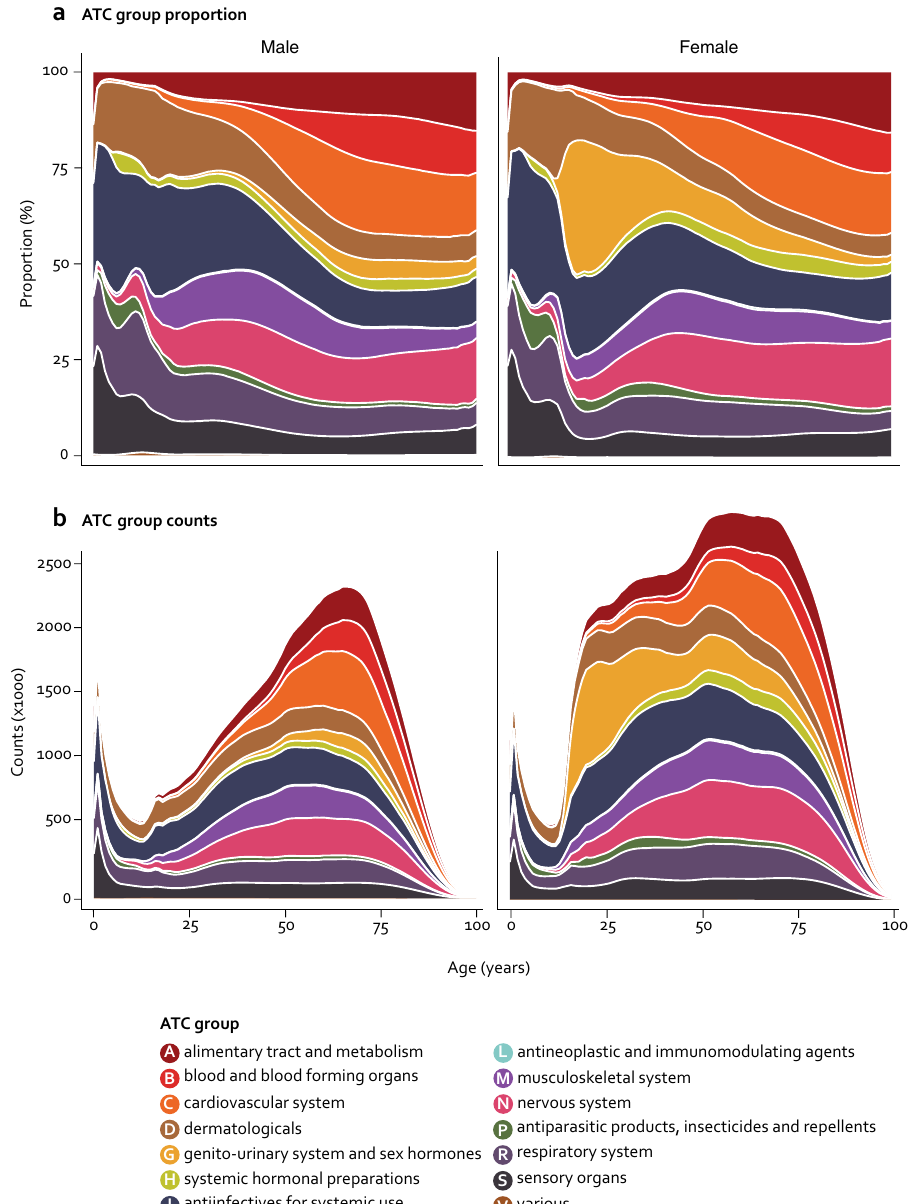
Fig. 1 Prescriptions redeemed at all Danish pharmacies in the period 1995-2019 strati fi ed by the 14 anatomical ATC groups for males (left) and females (right). a Proportion of different ATC groups against age at redemption. b Total counts of prescriptions against age at redemption. Color key according to anatomical ATC